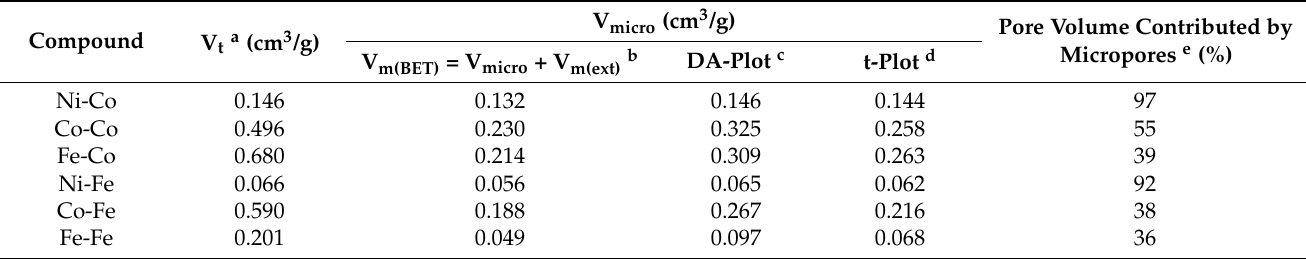
Table 7. Comparison of total volume (V t ) and micropore volume (V micro ) calculated according to different methods from N 2 adsorption